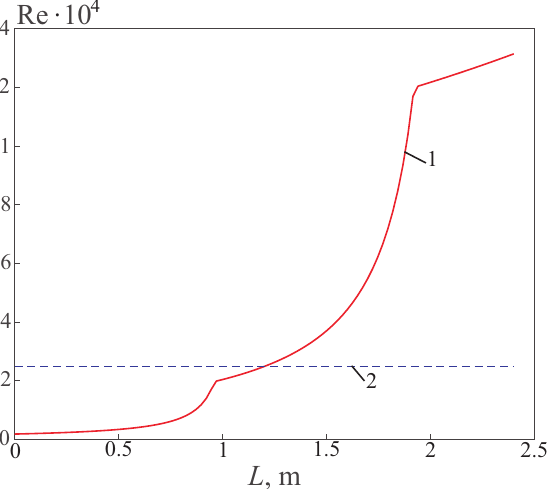
Figure 9. Distributions of oil Reynolds numbers along length. Line 1 corresponds to the numerical calculation at variable viscosity, and line 2 corresponds to the theoretical calculation.